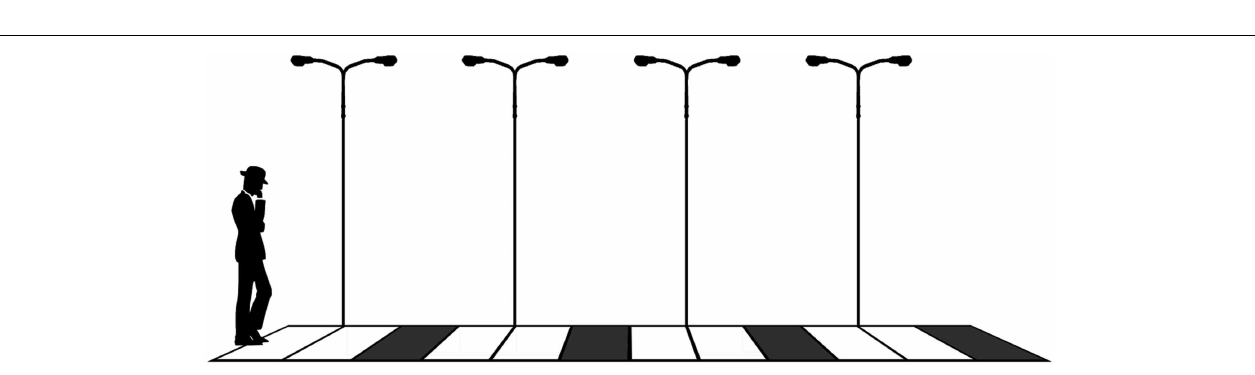
FIGURE 3 | Discrete-time Markov chain representing the decision process of an agent.